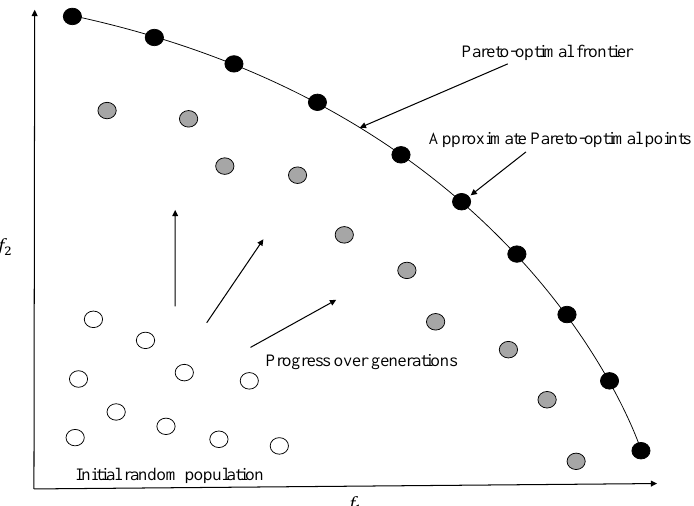
Figure 10. The working of a general evolutionary multi-objective optimization (EMO)